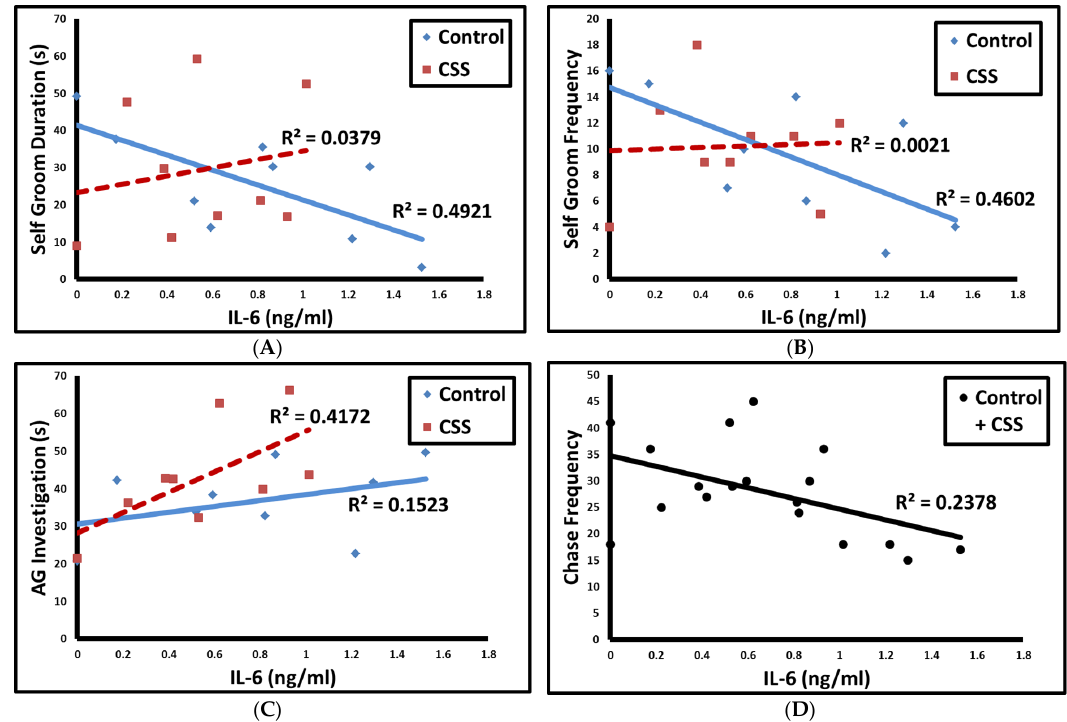
Figure 1. Correlations between IL-6 and self grooming duration ( A ); self grooming frequency ( B ); AG investigation duration ( C ); and chase frequency ( D ). Solid blue line = control, dashed red line = CSS, solid black line = both groups combined for chase frequency.